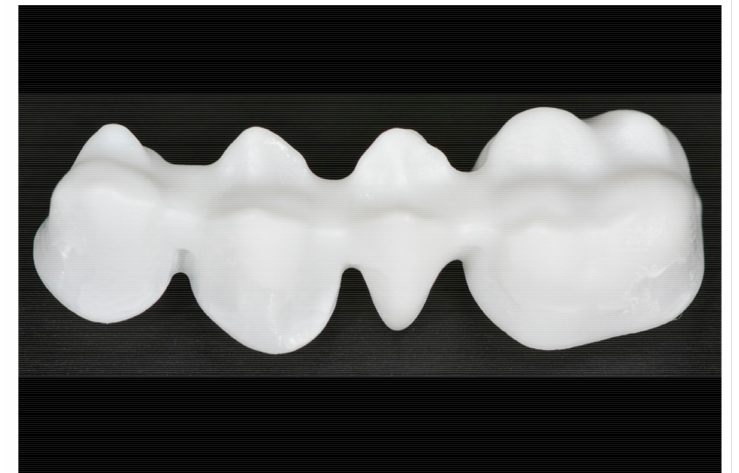
Figure 1. Zirconia four-unit